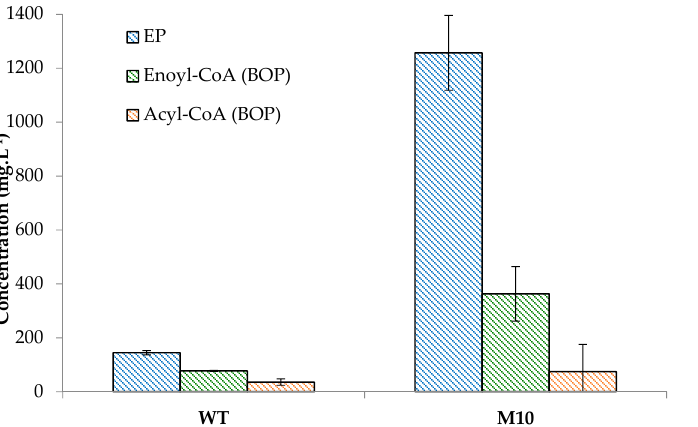
Figure 5. Concentration of esters from Ehrlich pathway (EP), and acyl-CoA and enoyl-CoA from β -oxidation pathway (BOP) in the wild-type and the mutant M10 of S. suaveolens . The VOCs were determined after 48 h of growth at 30 °C on YNB-Glu-Ile agar medium. Data shown are the mean ± SD of three independent cultures.